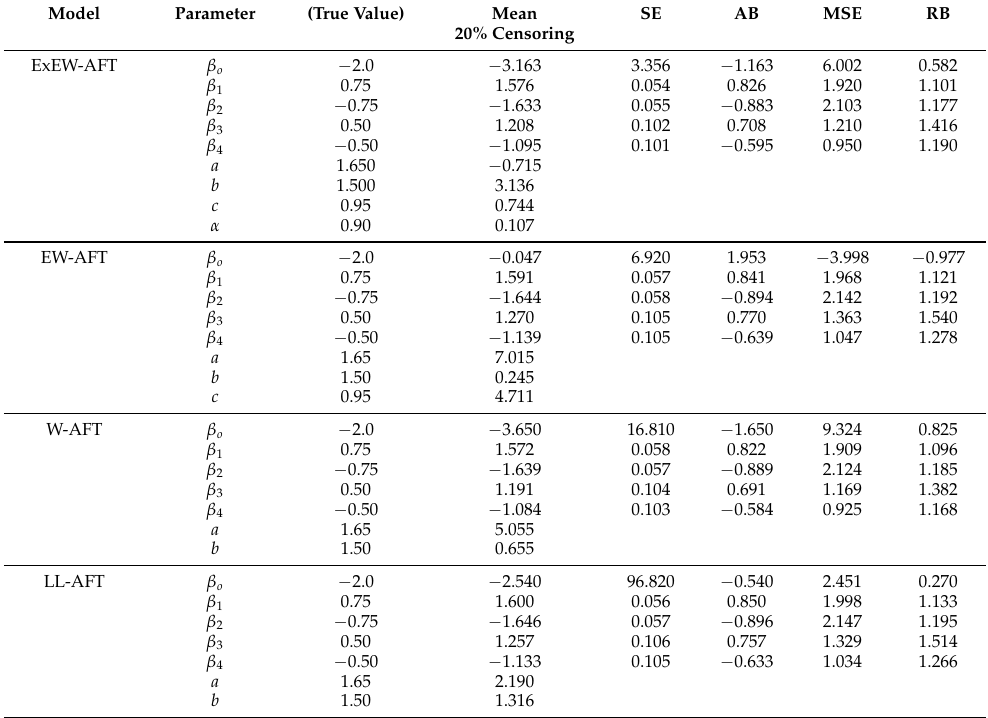
Table 14. Simulation study for scenario 4 ( n = 5000) with about 20% censored observations is used to compare model